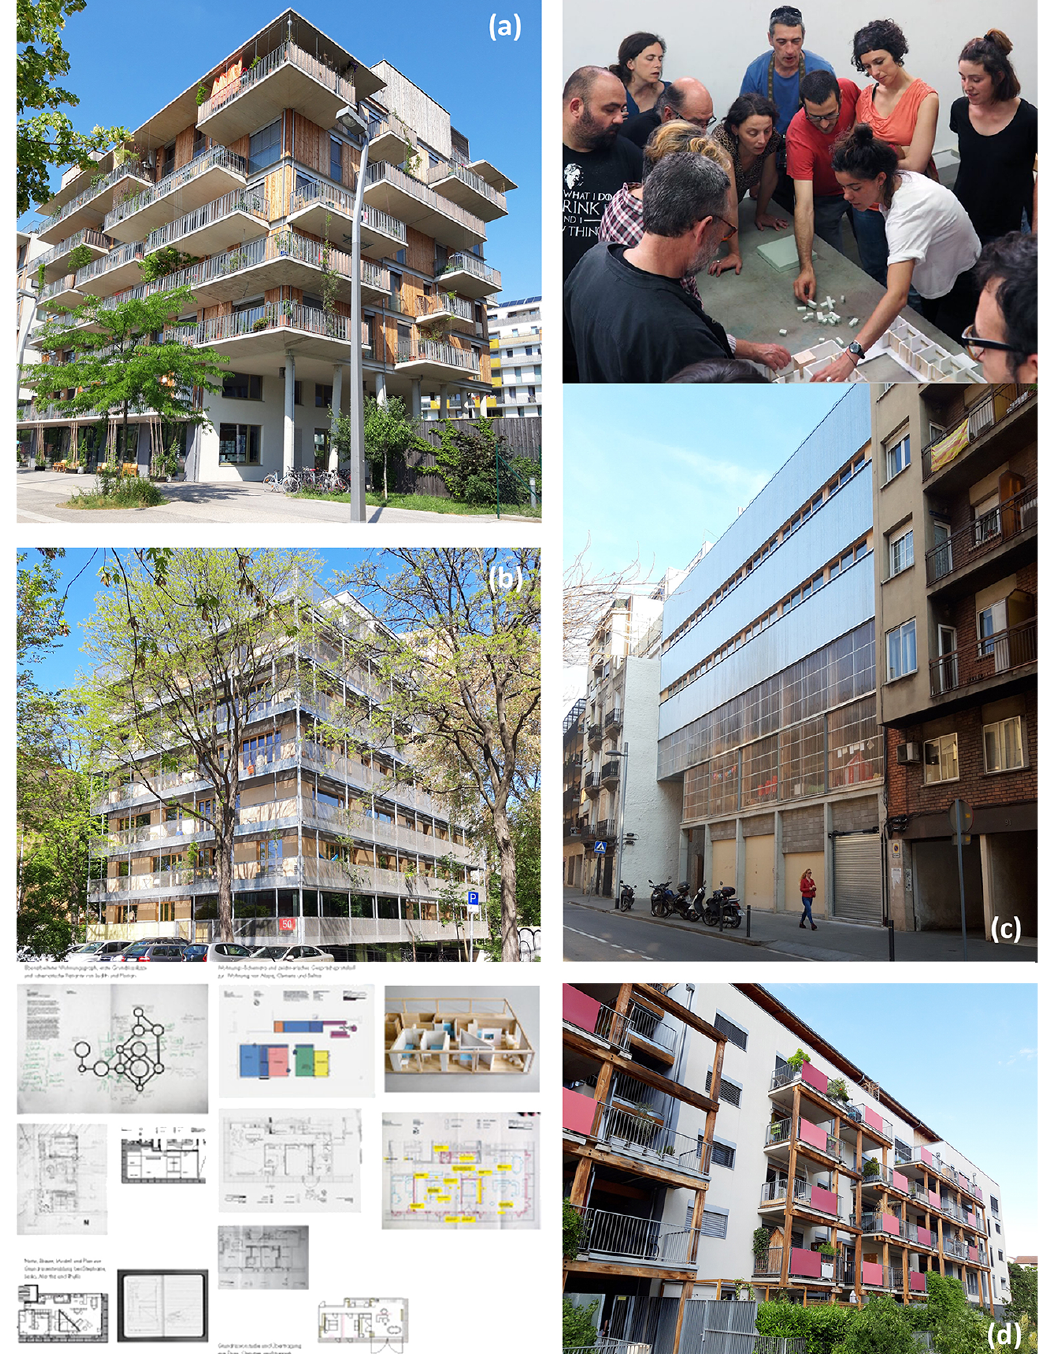
Figure 20. Examples of housing projects based on co-design processes: (a) Wohnprojekt Wien , Vienna (source: author); (b) R50 , Berlin (sources: exterior image by the author; image courtesy of ifau); (c) La Borda , Barcelona (sources: image courtesy of La Borda; exterior image by the author); (d) Village Vertical , Lyon (source: